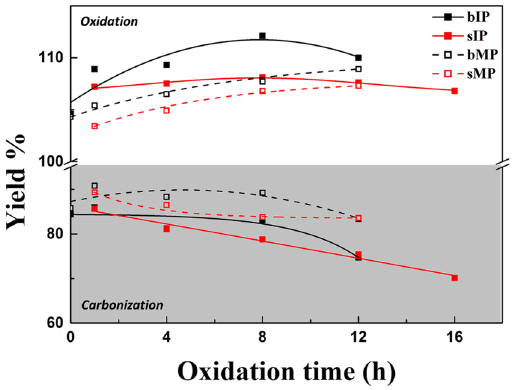
Figure 1. The yields of IP-based (filled squares and solid line) and MP-based (empty squares and dashed line) pitch fibers after oxidation and carbonization, prepared by batch (black)- and screw (red)-type extruder